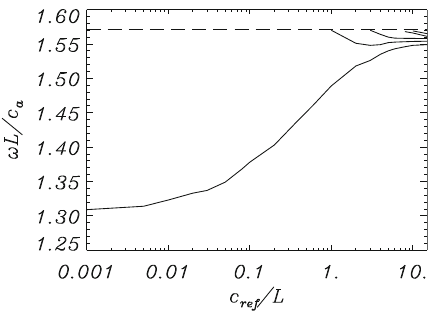
Fig.55 Dimensionlessfrequencyversusthedimensionlessreferenceseparationbetweenthreadsinamulti- thread system. In this figure c a is the Alfvén speed in the corona. Image reproduced with permission from Díaz et al. (2005), copyright by